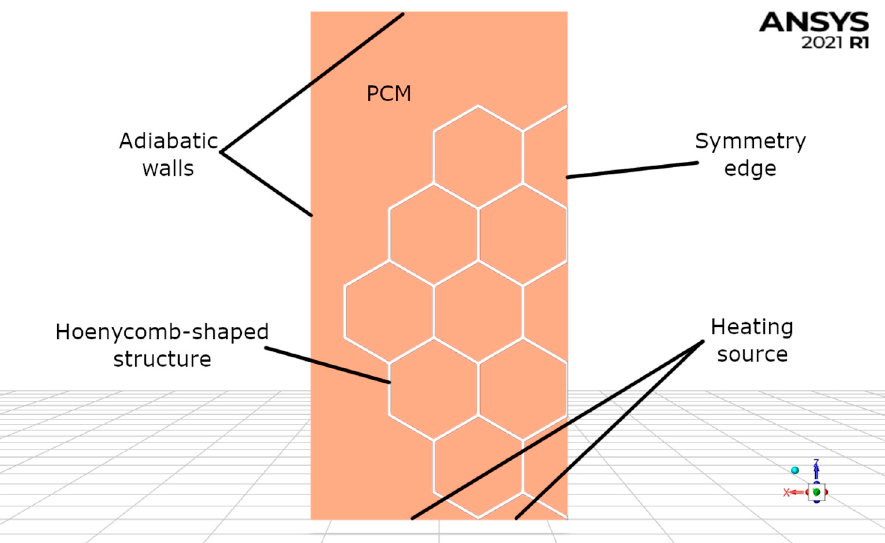
Figure 3. Boundary conditions employed during calculations. Images used courtesy of ANSYS, Inc.